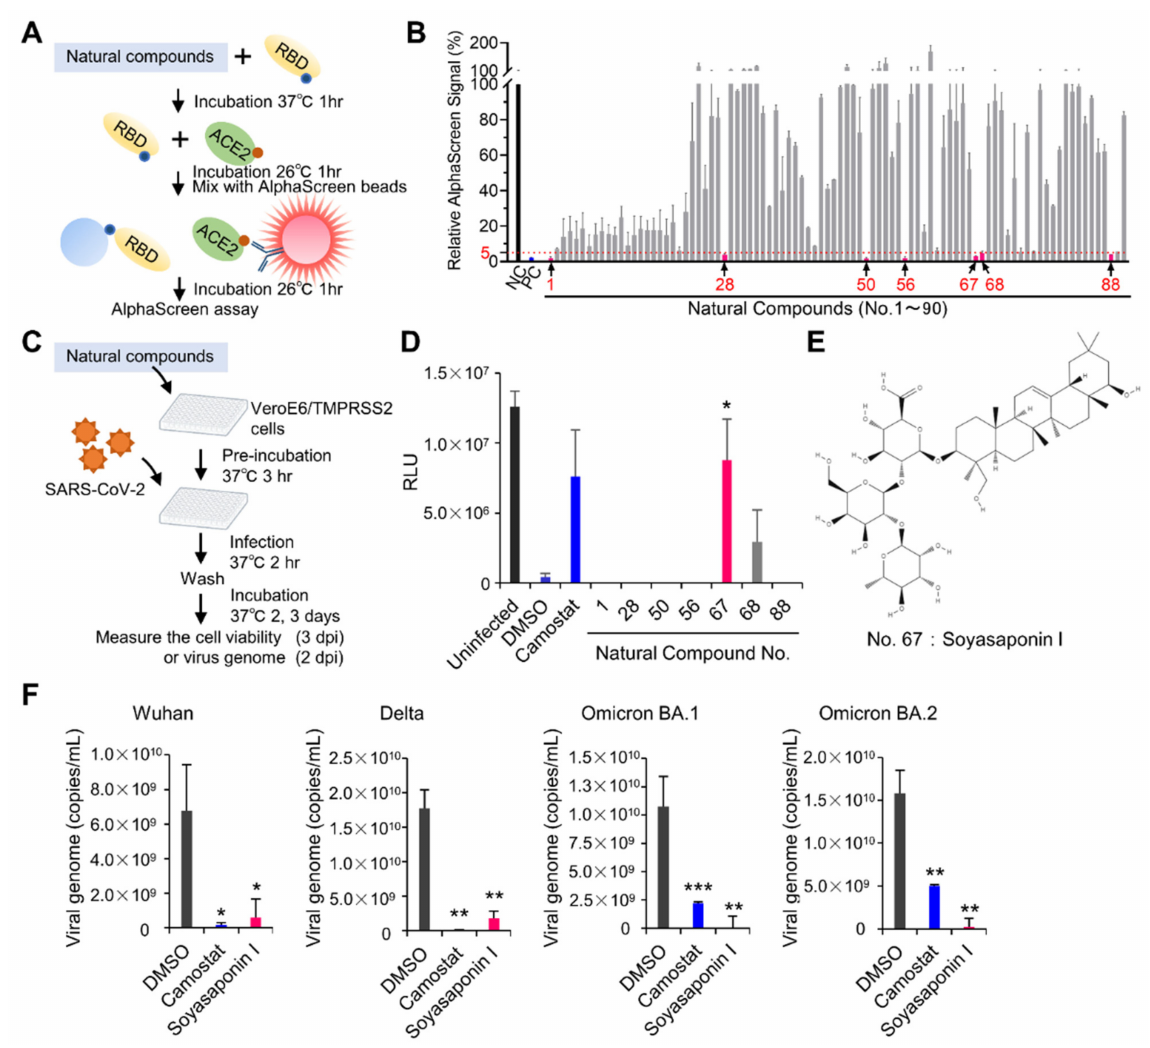
Figure 4. Application for drug screening using AlphaScreen assay to evaluate RBD–ACE2 interaction. ( A ) Schematic representation of drug screening using AlphaScreen assay. Ninety natural compounds were used for drug screening to inhibit RBD–ACE2 interaction in vitro. ( B ) AlphaScreen assay for drug screening. The relative AlphaScreen signal was calculated with DMSO as 100%. DTT was used as positive control (PC). Seven compounds with signals decreased to 5% or less were used for further screening. ( C ) Schematic diagram of infection assay to assess the antiviral effect of selected seven compounds. Antiviral activity of drug at a concentration of 100 µ M was evaluated using cell viability as an indicator after virus infection. dpi, days post-infection. ( D ) Result of infection assay. Here, 25 µ M of Camostat was used as a positive control. ( E ) Structure of drug No. 67: Soyasaponin I (PubChem Identifier: CID 122097). ( F ) Inhibitory activity of Soyasaponin I at a concentration of 100 µ M against different SARS-CoV-2 strains in infection assay. All graph data are presented as mean ± SD, Welch‘s t test (two-tailed), * p < 0.05, ** p < 0.01, *** p <